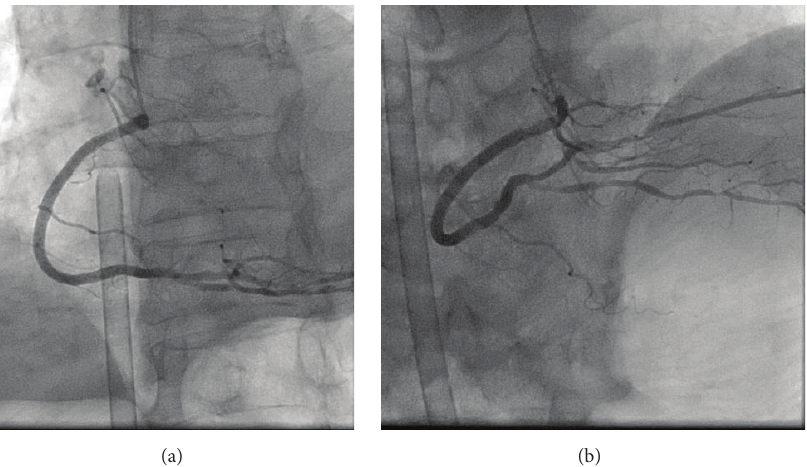
Figure 5: (a) Left anterior oblique view of the right coronary artery following insertion of the percutaneous cardiopulmonary support (PCPS) cannula. (b) Cranial view of the right coronary artery following PCPS cannula insertion.